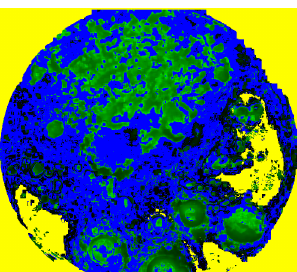
Figure 17. The final frame of petri dish 2, with four locations marked on different colonies, from which population curves are extracted and modeled.